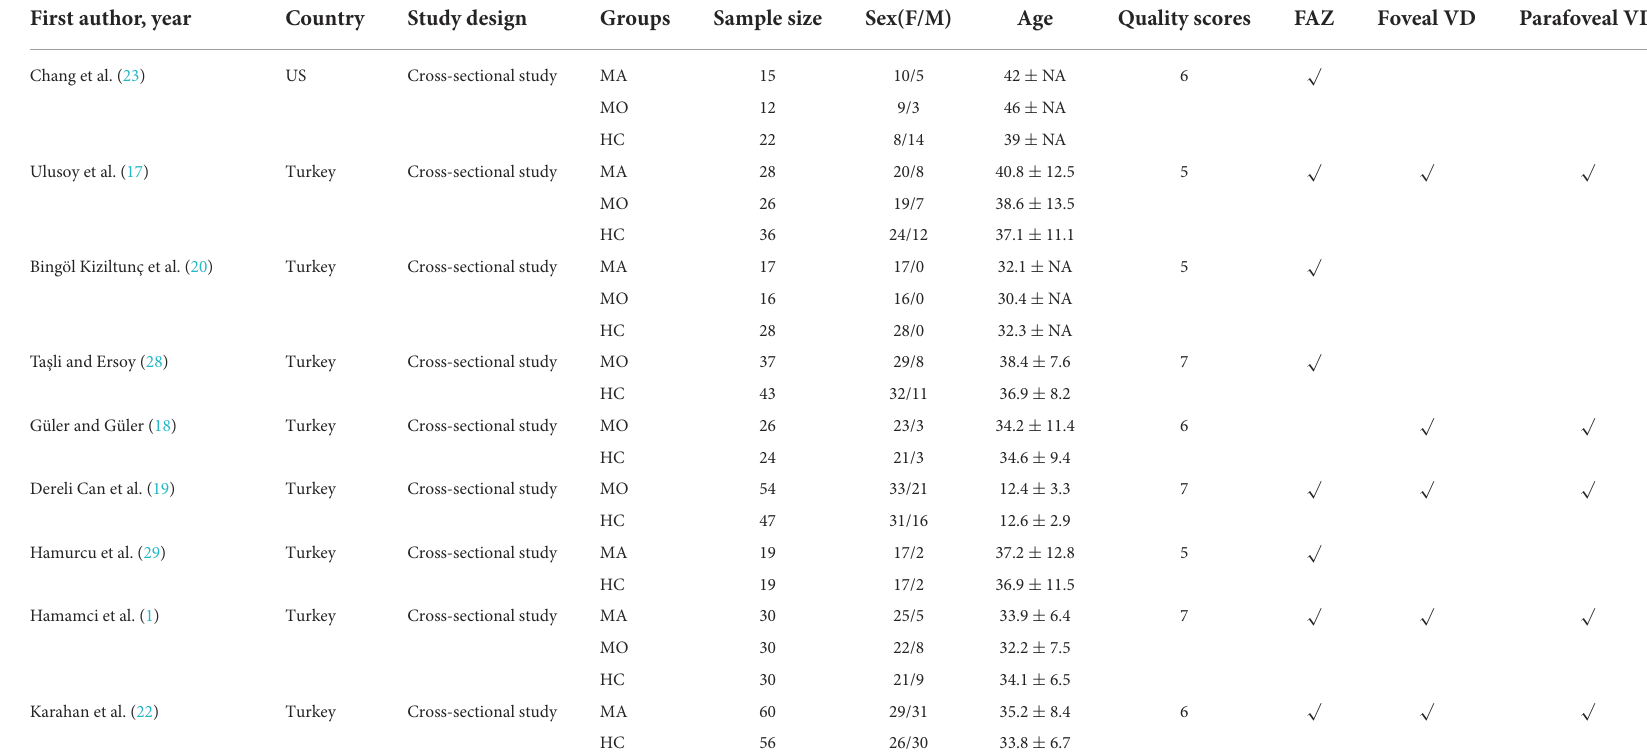
TABLE 1 Study design and patient characteristics of included